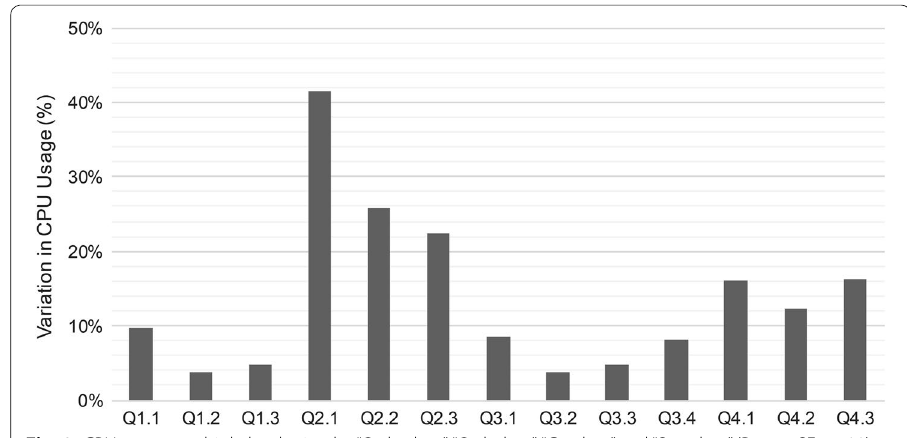
Fig. 8 CPU usage: multiple bucketing by “Orderdate”, “Orderkey”, “Custkey” and “Suppkey” (Presto, SF